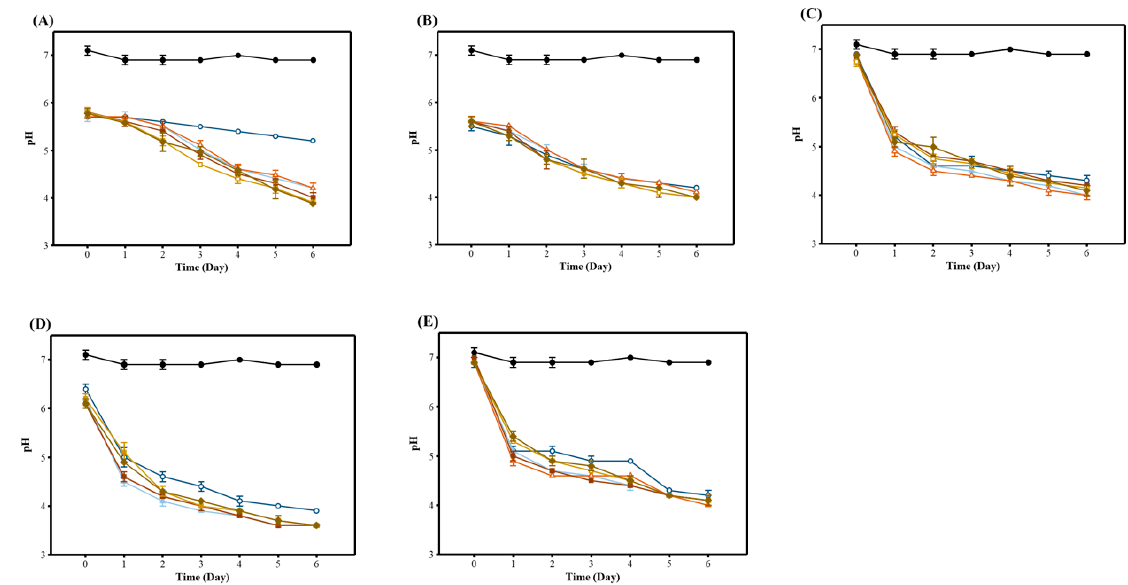
Table 1. Changes in the pH of fermented rice water according to the lactic acid bacteria and enzymes used in the treatments.